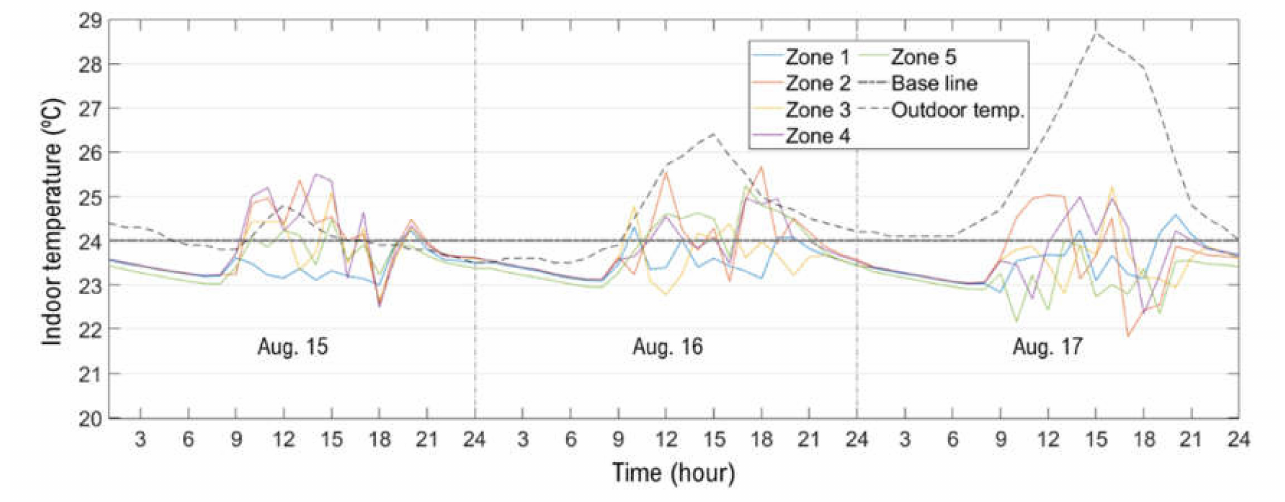
Figure 3. Comparison of optimized indoor operating